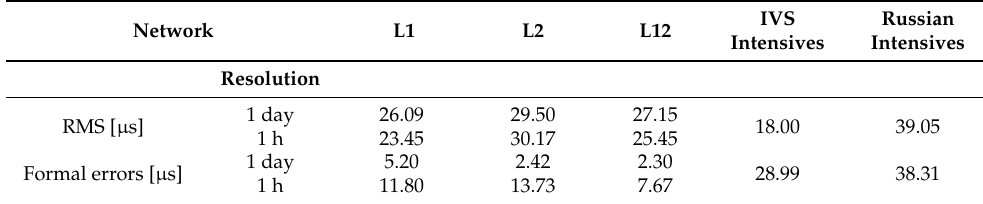
Figure 5. dUT1 estimates with respect to finals.all (IAU2000) derived from L1, L2, and L12 networks, IVS and Russian Intensives, and VGOS networks for daily resolution (using global solutions). Table 5. The root mean square and mean formal error values of dUT1 from legacy, and Intensive sessions for daily and hourly resolution. Unit: µ s.